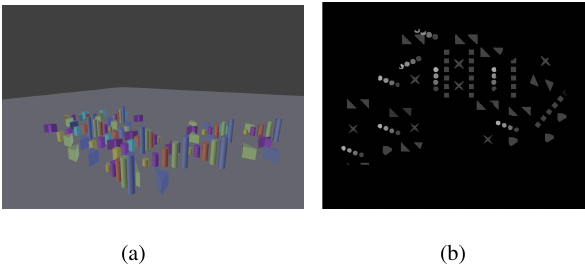
Figure 6: Image used in order to assess features detectors a) 3D scene used to generate the orthoimage ; b) Orthoimage obtained thanks to the 3D scene (simulated data) Based on these images, the repeatability criterion of Shi-Tomasi, SIFT, SURF and ORB detectors has been calculated. The evalu- ations were performed for rotations and translations transforma- tions.